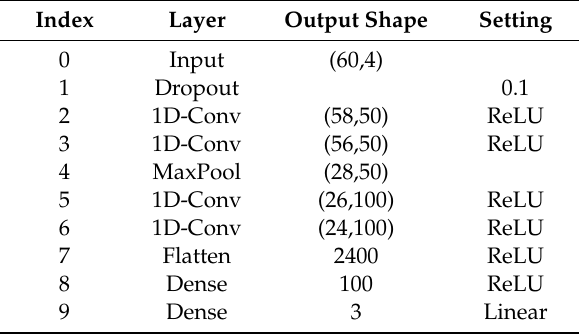
Table 1. Layers of convolutional neural networks.